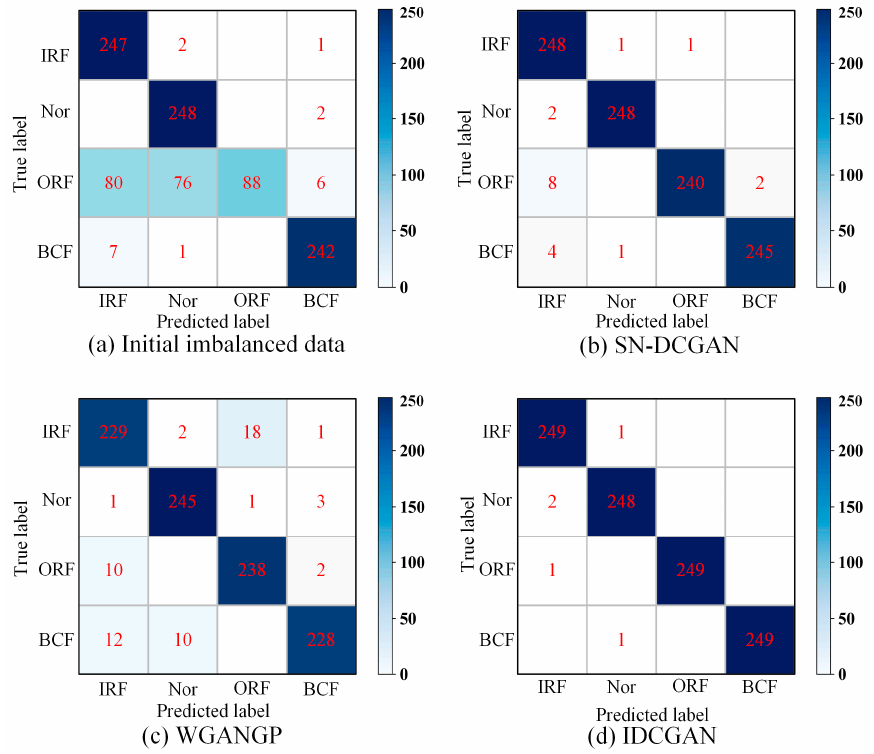
Figure 11. Confusion matrixes based on ResNet and different generation methods under limited ORF conditions with imbalance ratio of 0.1. Table 3. Diagnosis results of different minority faults with imbalance ratio of 0.2.